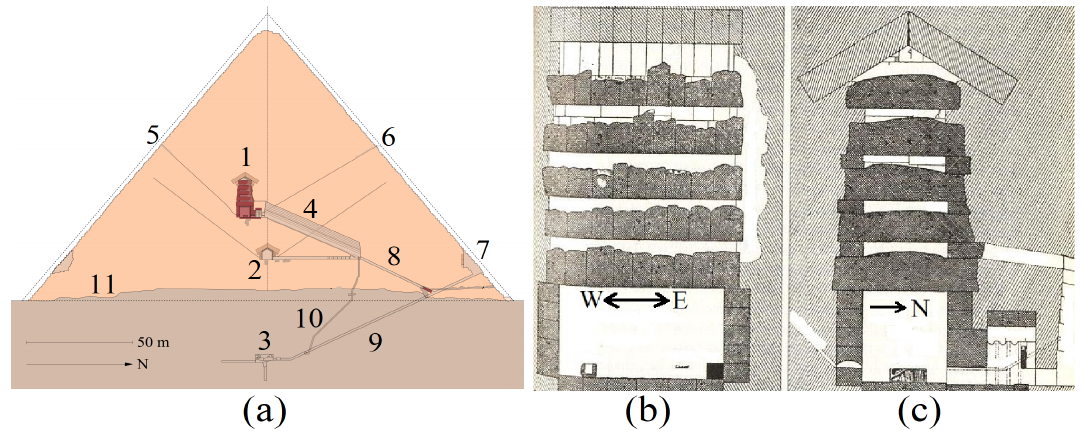
Figure 2. Khnum-Khufu diagram of the known interior structures. ( a ): East-side schematic view. ( b ): South-side view of the ZED. ( c ): East-side view of the